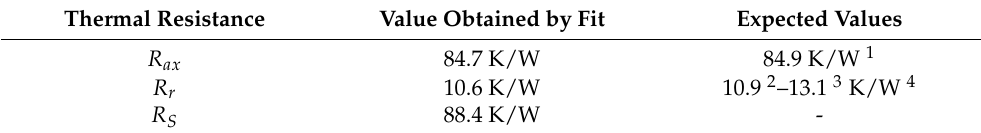
Table A1. Thermal resistances R ax , R r , R S obtained by fitting compared to nominal expected values. Thermal Resistance